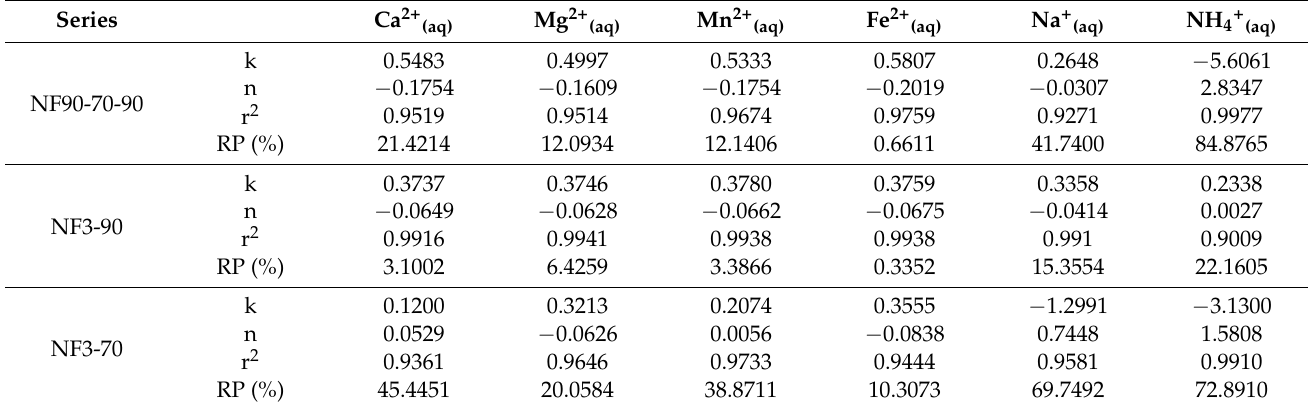
Table 5. Average relative permeabilities, slopes, intercepts (n), and linear regression measure of all obtained MIRA vs. FE